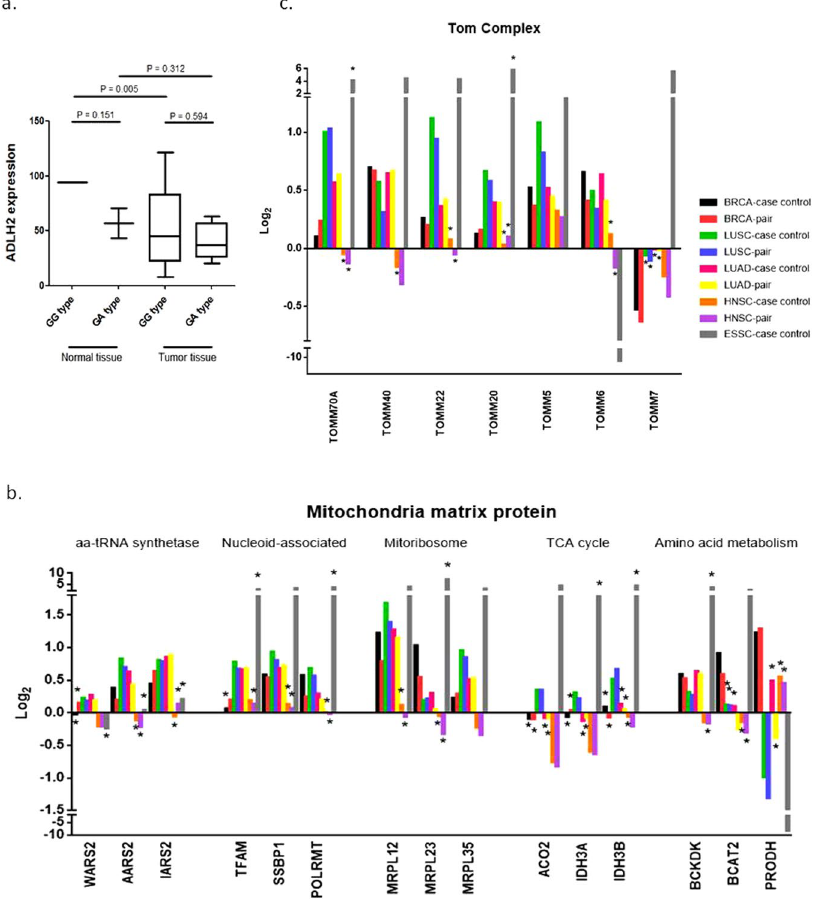
Figure 5. Correlation with ALDH genotyping, expression and other mitochondria-associated proteins. ( a ) Downregulation of ALDH2 is generally observed between wild types (rs671 GG) and heterozygotes (rs671 GA). Data from the Taipei Veteran’s General Hospital cohort. Y-axis denotes the reads per kilobase of exon model per million mapped reads (RPKM) value. ( b ) Expression of candidate genes (baseline) with functional group annotations (top) for mitochondria matrix proteins are shown among the 5 cancers. ( c ) Mitochondrial TOM complex. BRCA: breast cancer, LUSC: lung squamous cell carcinoma, LUAD: lung adenocarcinoma, HNSC: head and neck squamous cell carcinoma, ESSC: esophageal squamous cell carcinoma, case-control: all tumor vs. normal, pair: pairwise tumor vs. normal. All p-values > 0.05 were marked with an asterisk ( *